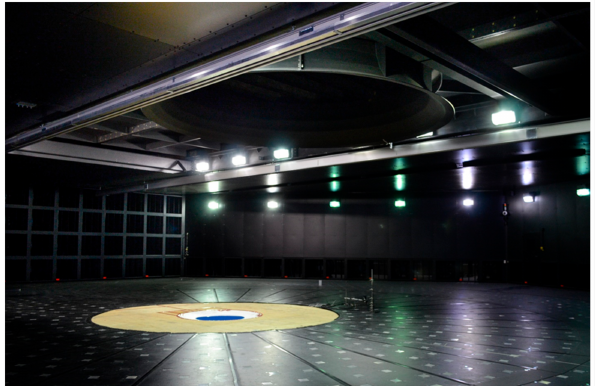
Figure 1. WindEEE Dome chamber showing the 60-fan wall and bell mouth (Hangan et al., 2017) [35]. Wind Profiles